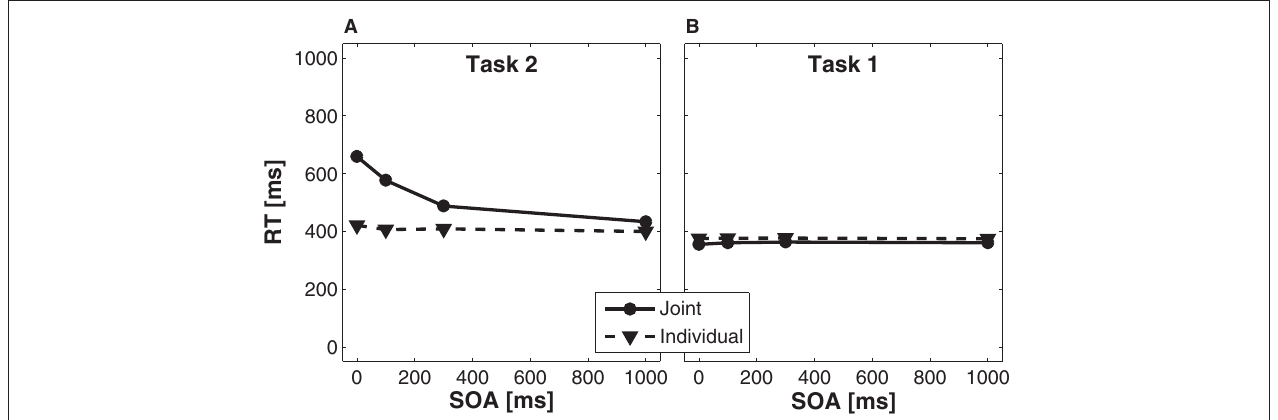
FIGURE 3 | Effects of stimulus onset asynchrony (SOA) on reaction times of Task 2 (A) and Task 1 (B), separately for the joint (solid lines) and individual (dashed lines) condition.